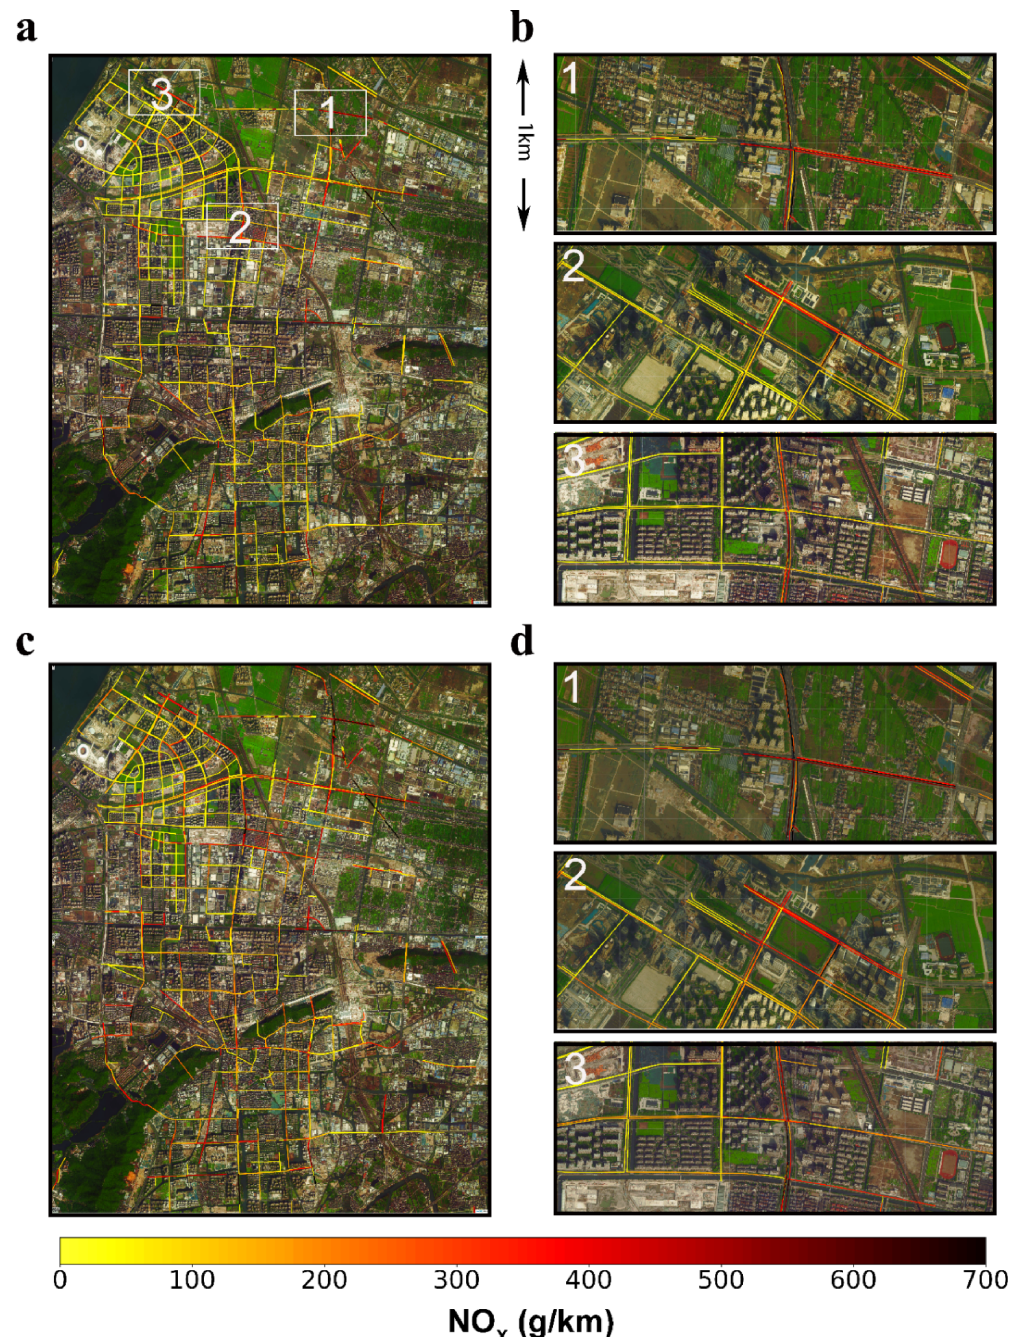
relationships (Fig. 6). An unconstrained three-parameter ex- ponential model, E(d) = α + β exp ( − 3 d/k) , reproduced the emission–distance relationship E(d) with high fidelity ( r 2 = 0 . 96). Specifically, the isotropic parameter d reflected the distance to the hotspot cores ( m ); the background param- eter α represented the background emissions far from the